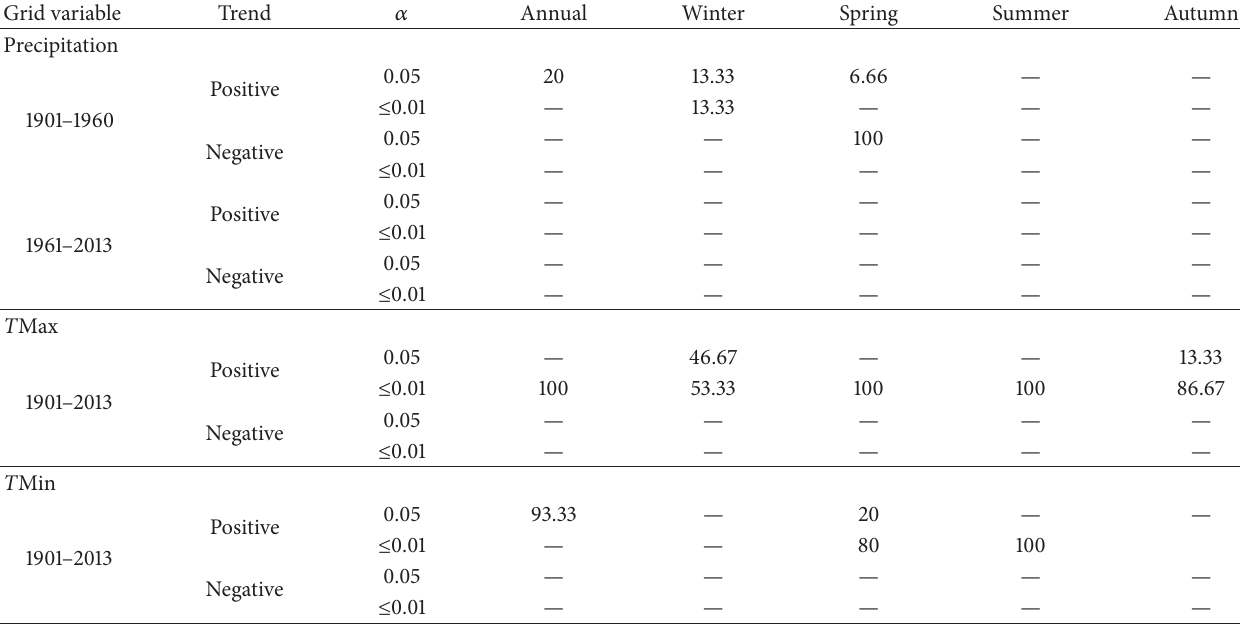
Table 5: The percentage of the grid points having significant trends by TSA of annual and seasonal data.